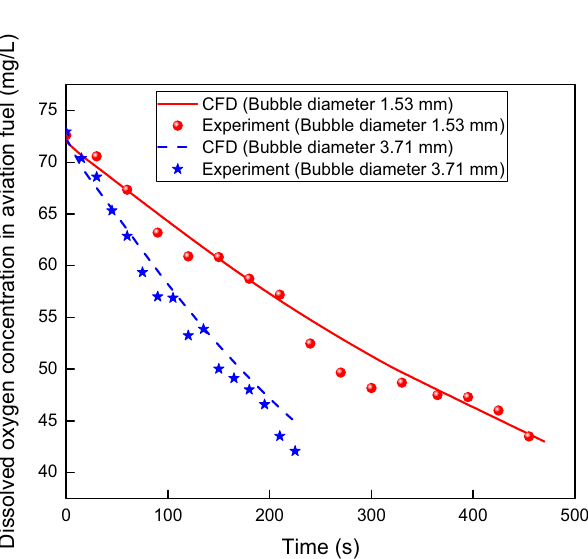
Figure 5. Comparison of dissolved oxygen concentrations between CFD simulation and